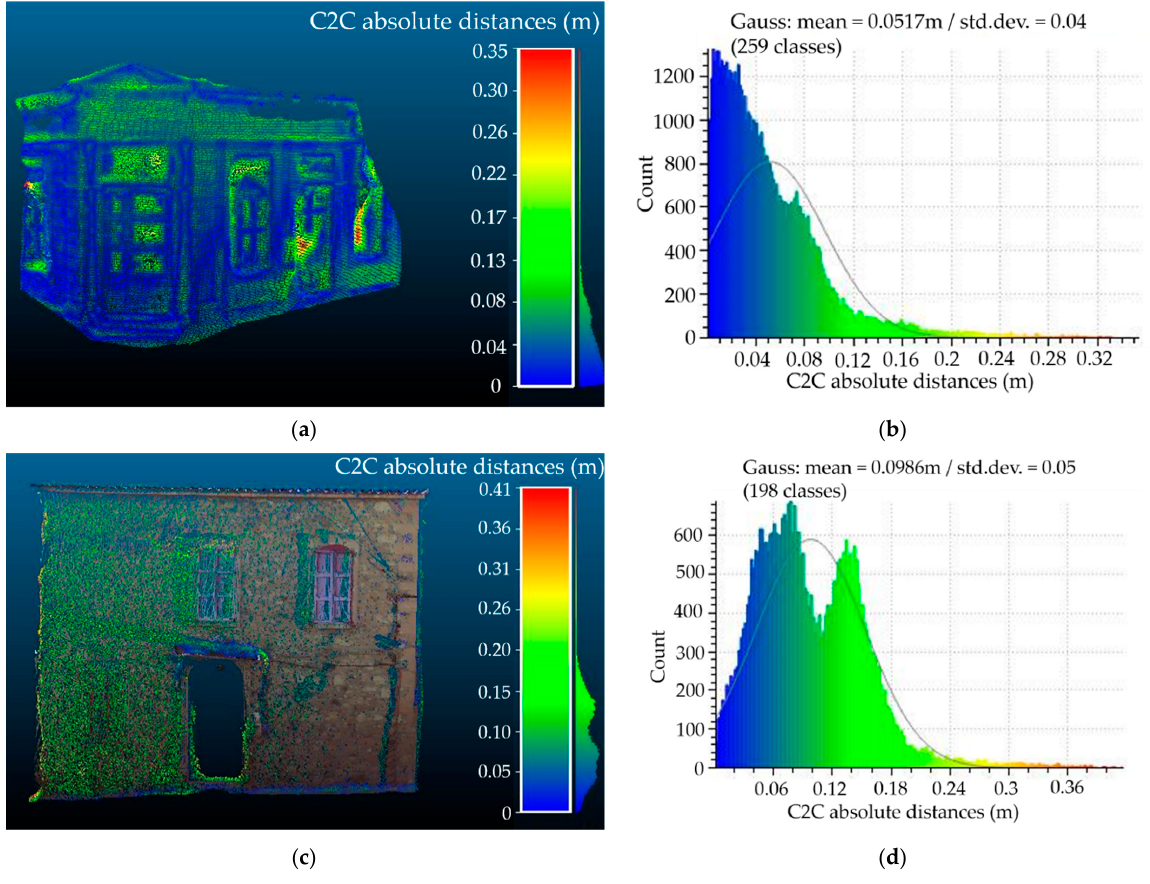
Figure 8. Cloud-to-cloud distance method results: ( a ) mean distance is 5 cm for building A, ( b ) histogram of the results (standard deviation = 0.04), ( c ) mean distance is 9 cm for building B, ( d ) histogram of the results (standard deviation = 0.05).